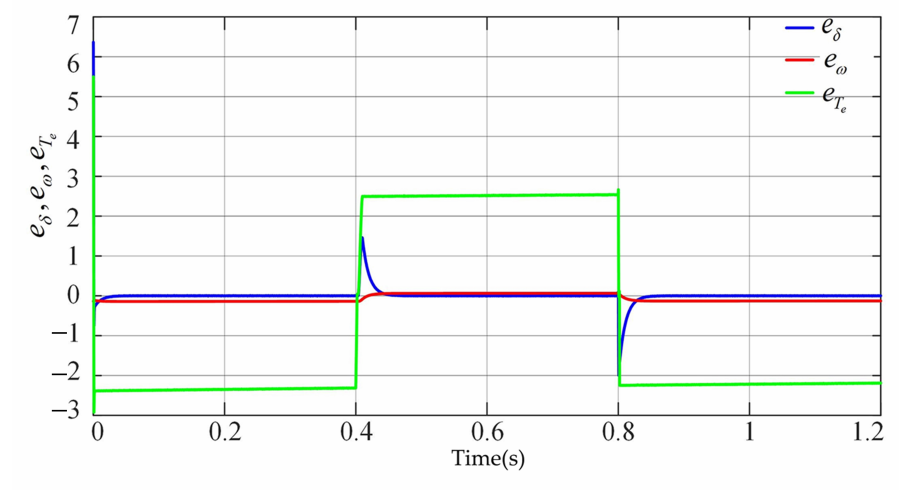
Figure 14. System tracking errors e δ , e ω , and e T